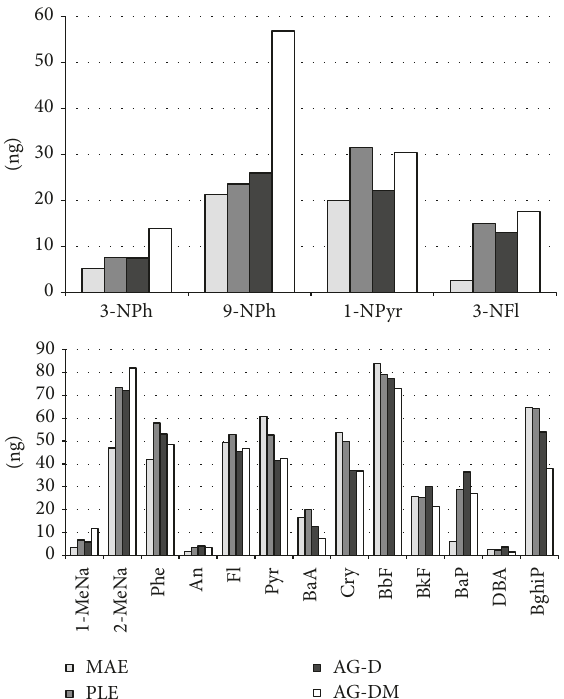
Figure 1: Mean values (ng per subsample) of selected PACs measured studied extraction methods. The abbreviations for PACs and extraction procedures are expanded in Reagents and Standards and Samples and Preparation,